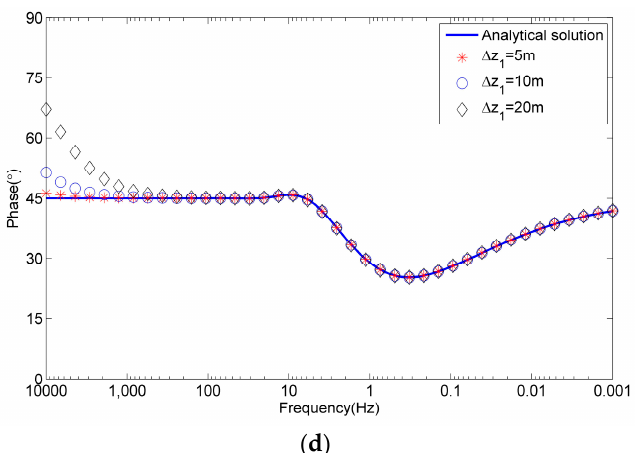
Figure 4. Comparison of FD solution and analytical solution for the two-layered model. ( a ) Apparent resistivities of TM-mode; ( b ) Apparent resistivities of TE-mode; ( c ) Phases of TM-mode; ( d ) Phases of TE-mode.